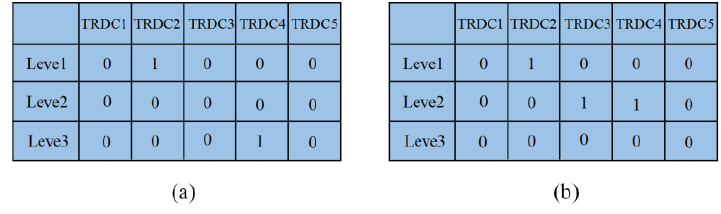
Figure 2. An encoded chromosome for emergency facility location.